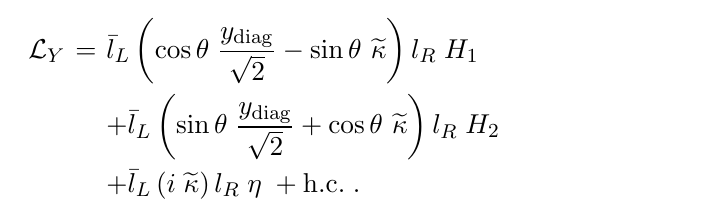
Figure 1 . The long-lived state (cid:17) with m (cid:17) < 2 m e decays predominantly to a (cid:13)(cid:13) (cid:12)nal state. The Yukawa couplings of the scalar mass eigenstate are explicitly written